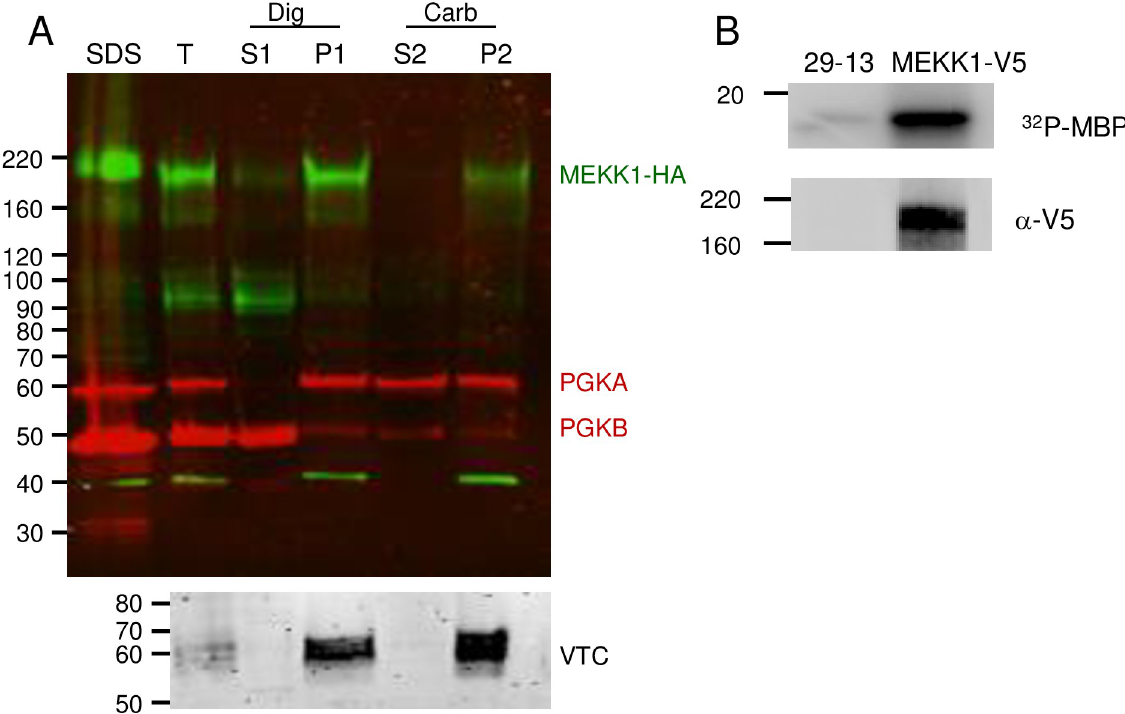
Fig 7. MEKK1 is an integral membrane protein which has protein kinase activity. A) Cell fractionation. PF cells expressing MEKK1-HA were fractionated by digitonin treatment followed by carbonate extraction. After separation by SDS-PAGE and blotting, the blots were probed with mouse anti-HA (green) and rabbit anti-phosphoglycerate kinase (red) which detects the 56 kDa glycosomal form (PGKA) and the 47 kDa cytosolic isoform (PGKB). A parallel blot was also incubated with antibody to the acidocalcisome membrane protein vacuolar phosphatase (VTC). SDS, SDS lysate; T, total after incubation with digitonin; S1, digitonin supernatant; P1, digitonin pellet; S2, carbonate supernatant; P2, carbonate pellet. Lanes contain fractions from 3 × 10 6 cells. B) Kinase activity. Immunoprecipitated MEKK1 from PF was incubated with γ 32 P-ATP and the exogenous substrate myelin basic protein (MBP), followed by SDS-PAGE and transfer to nitrocellulose. A control immunoprecipitation used the untransfected parental line (29–13). Top: phosphorimaging demonstrates phosphorylation of MBP. Bottom: the blot was probed with anti-V5 mAb demonstrating the pulldown of the tagged protein.